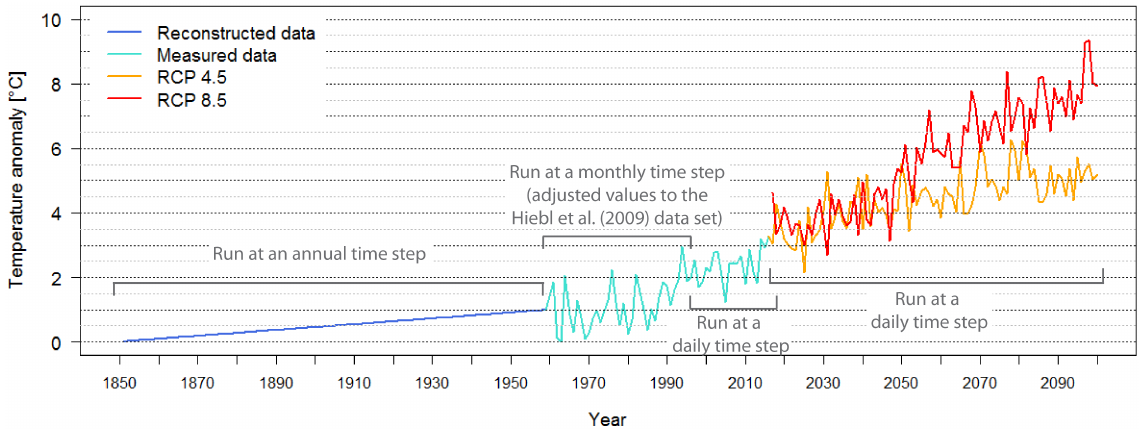
Figure 4. Forcing air temperature data displayed at an annual time step. For running the transient models, the time step was refined for some periods as described on the